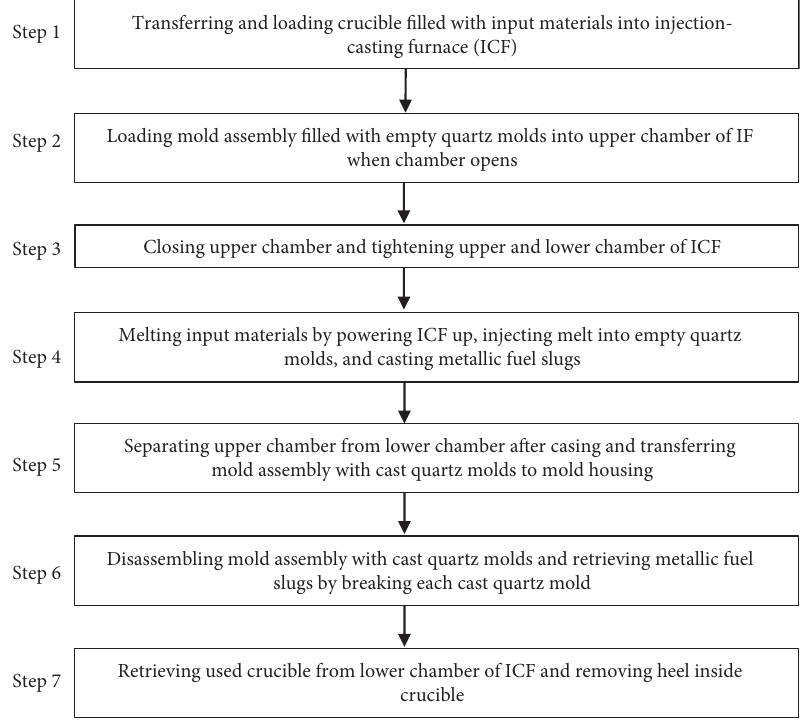
Figure 6: Procedure for metallic fuel slug